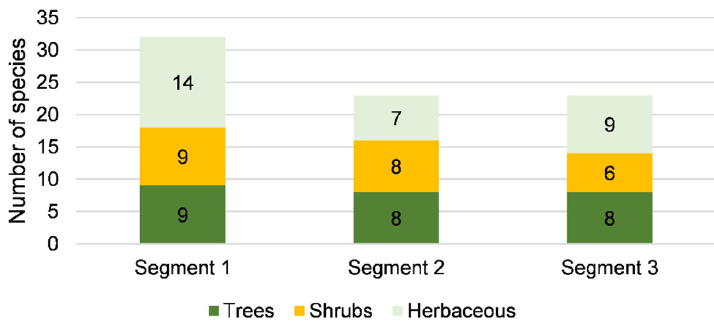
Figure 8. Number of plant species per type.